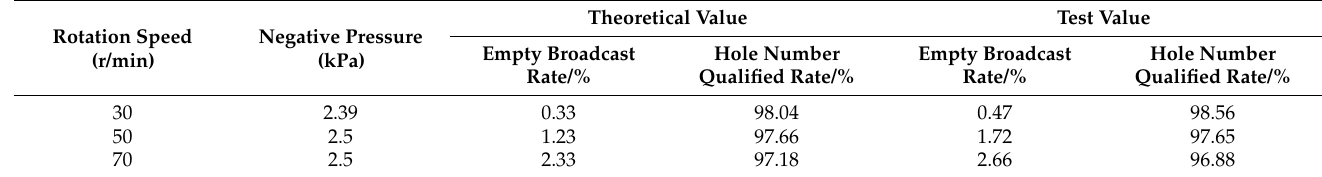
Table 6. Optimization results and test